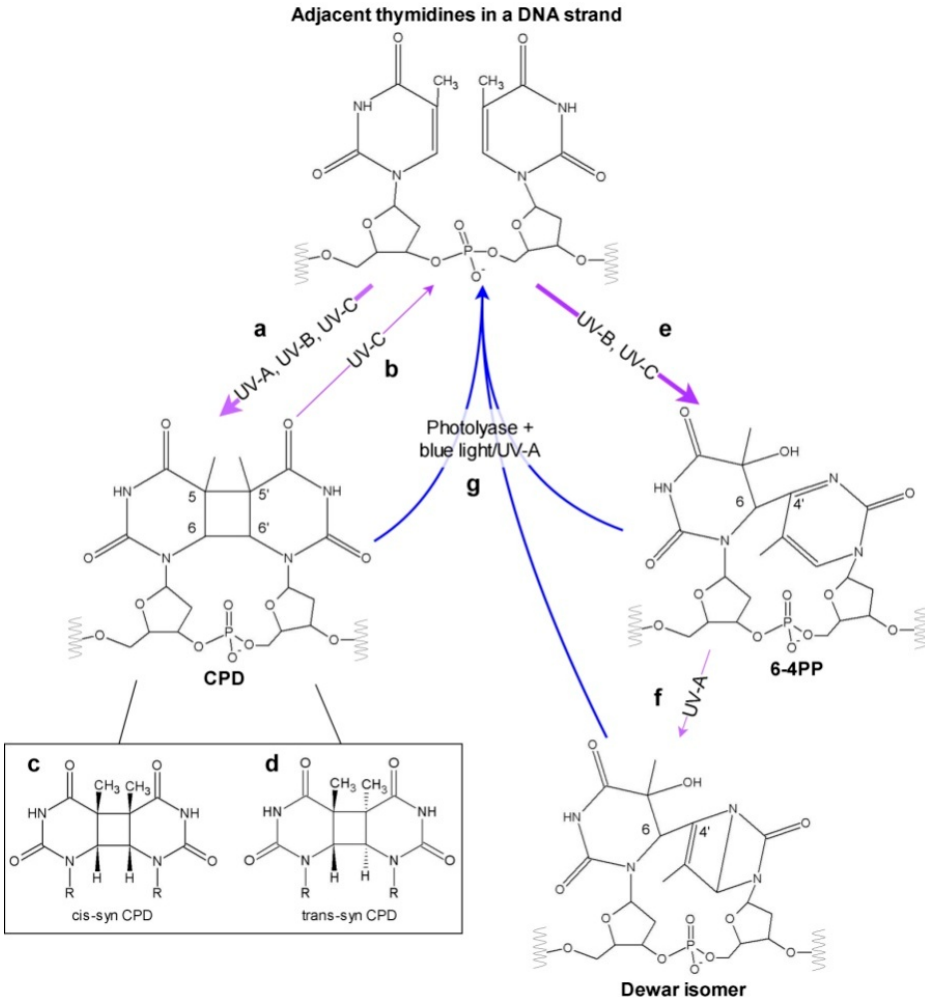
Figure 2. Diagram showing possible effects of different UV types on neighboring pyrimidines in a DNA strand. Absorption of UV-A, UV-B, UV-C may cause the formation of CPD ( a ), which can be split back by UV-C ( b ). Depending on the conformation of the two adjacent bases at the time of irradiation, different CPD stereoisomers can occur—mainly cis-syn CPD ( c ) and less frequently trans-syn CPD ( d ). 6-4 PPs are created upon absorption of UV in the UV-B or UV-C range ( e ), and can subsequently isomerize to Dewar photoproducts in UV-A ( f ). All three types of photoproducts can be repaired by photoreactivation performed by photolyases requiring blue or UV-A light ( g ), or by dark repair mechanisms (not shown). Thick and thin purple arrows mark the prevalent and less frequent processes, respectively.